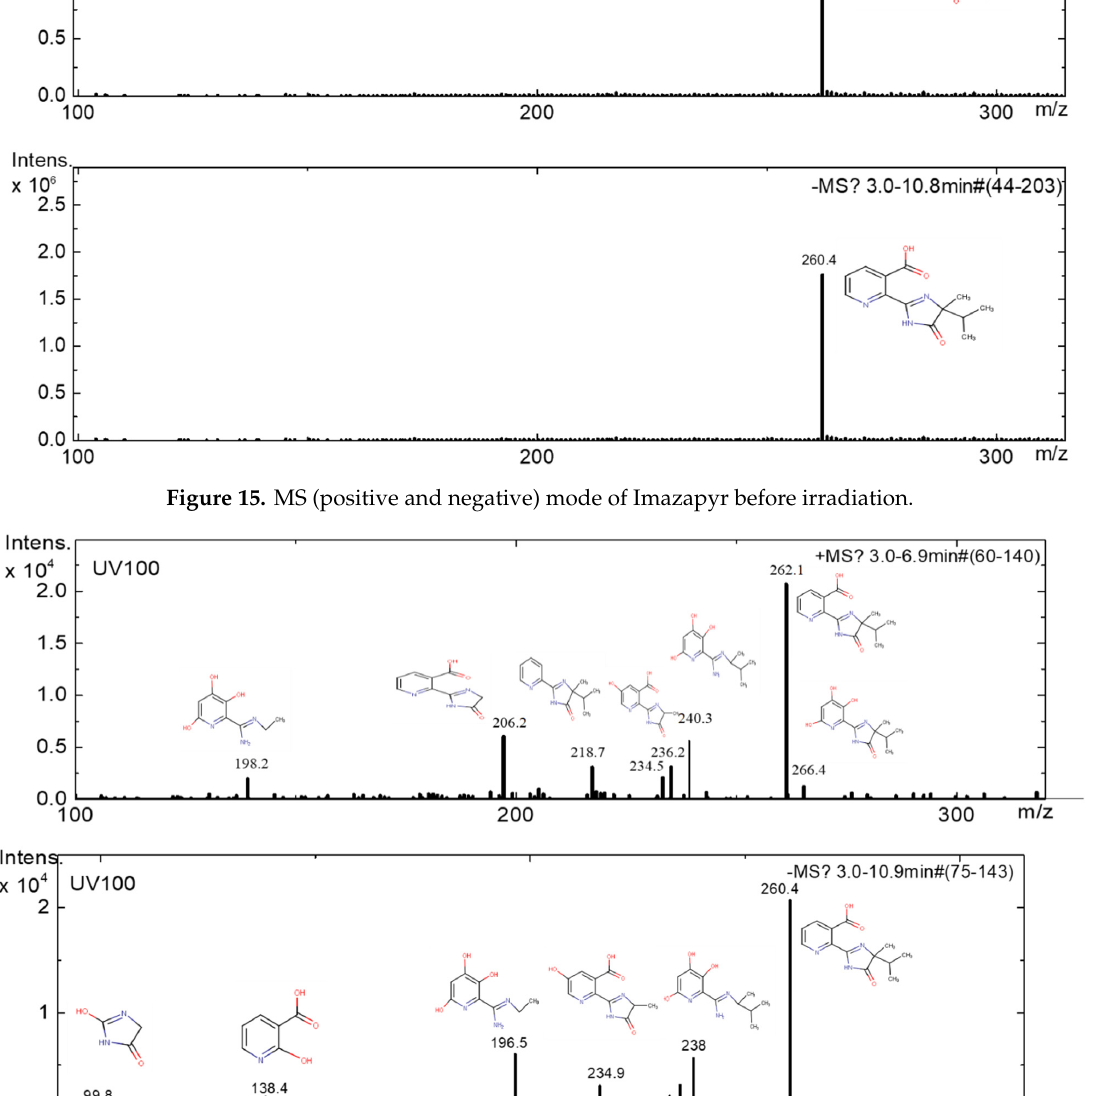
Figure 16. MS (positive and negative) mode of products generated after 300 min of irradiation using TiO 2 photocatalyst.